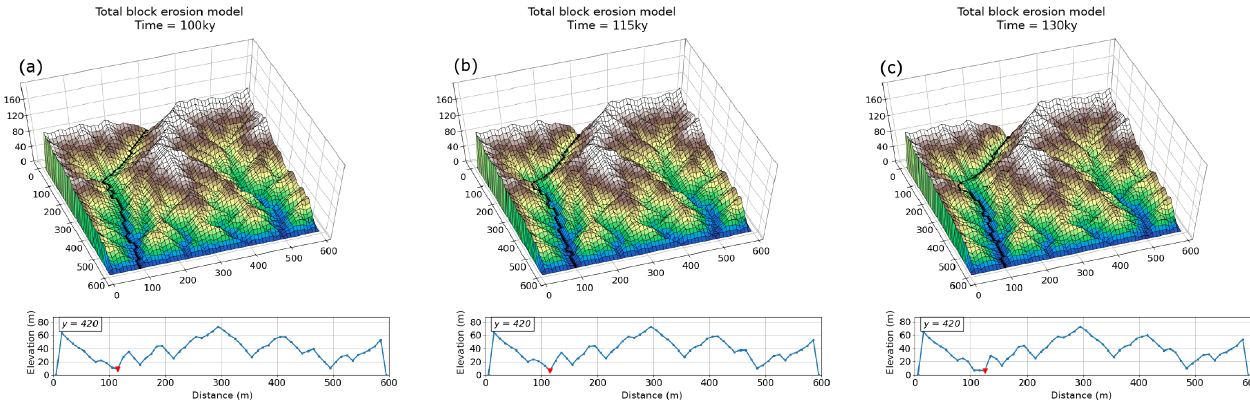
Figure 8. Surface topography and cross section at y = 420 during the period of increased water flux for the total block erosion models. The red triangle on cross sections indicates the channel position. (a) Total block erosion model with low K and K l /K v = 1 . 0 at 100kyr before the increase in water flux. Note that this model looks similar to the spin-up model runs with no lateral erosion. (b) After 15kyr of increased water flux, the cross section shows vertical incision in the channel and increased relief between the channel and the hillslopes. (c) At 30kyr after water flux increased, equilibrium is reached. Lateral erosion can begin and the valley widens to 20m at y =